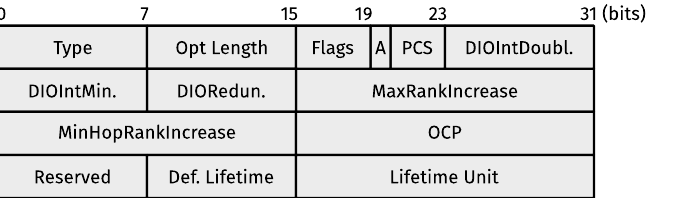
Figure 3. Format of a DODAG Configuration option. Note that a DODAG Configuration option is an RPL Control Message option with option Type = 0x04. In practice, it is only ever used to append DIO